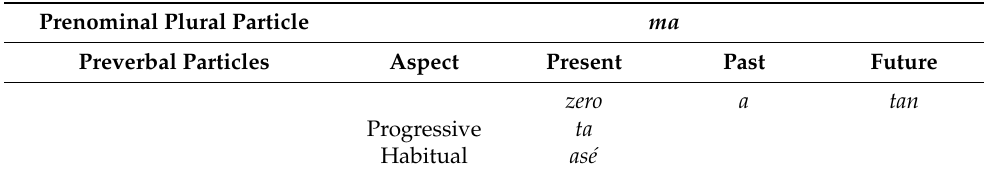
Table 1. Prenominal and preverbal particles in